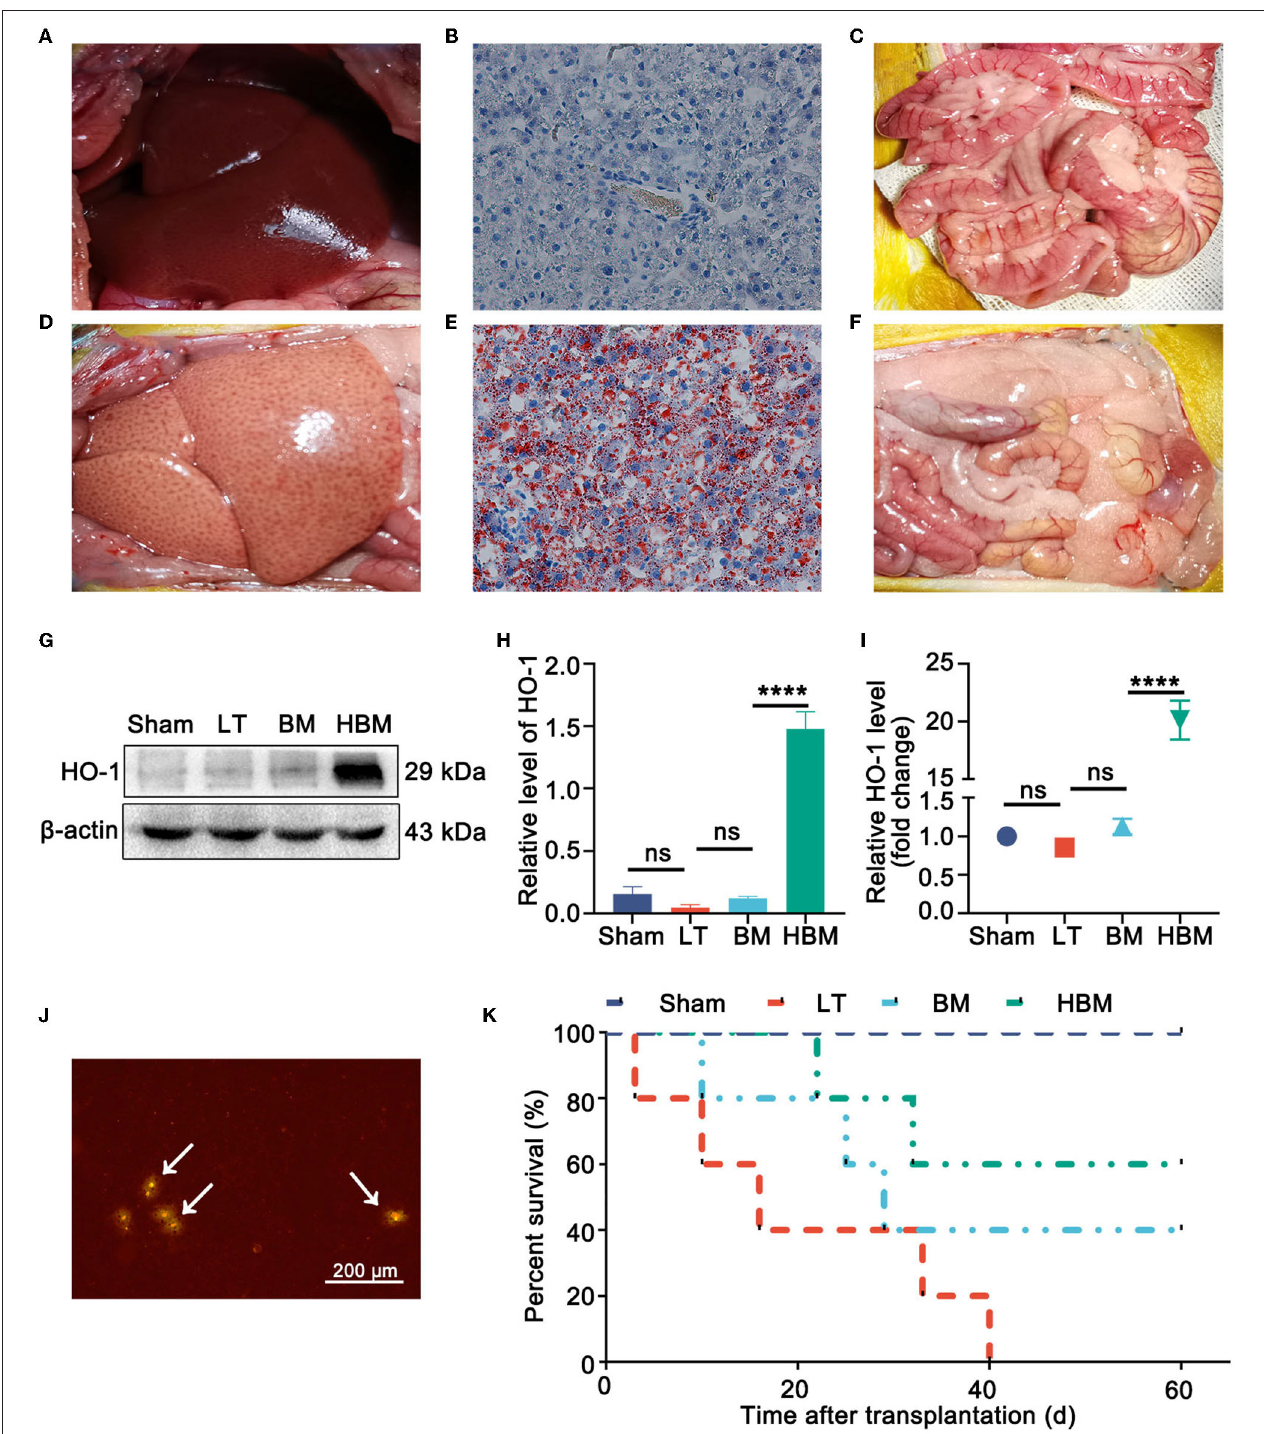
FIGURE 1 | Steatotic liver graft morphology, stem cell distribution, and recipient survival. (A) Normal rat liver. (B) Oil red staining of a normal liver. (C) Normal rat gut. (D) Rat steatotic graft liver. (E) Oil red staining of steatotic liver grafts ( × 200). (F) Fat in the intestine of a donor rat. (G,H) On POD 7, the level of the HO-1 protein was the highest in the HBM group. (I) On POD 7, the expression of Hmox1 mRNA was obvious in the HBM group. (J) Liver tissue frozen section of a steatotic donor liver ( × 40). GFP/BMMSCs colonization in the hepatic sinusoids could be observed by fluorescence microscopy. Arrows point to BMMSCs. (K) Survival time after liver transplantation for the steatotic donor livers. The median survival times of the Sham, LT, BM, and HBM groups were > 60, 16, 29, and 60 d, respectively. * P < 0.05, ** P < 0.01, *** P < 0.001, **** P < 0.001.